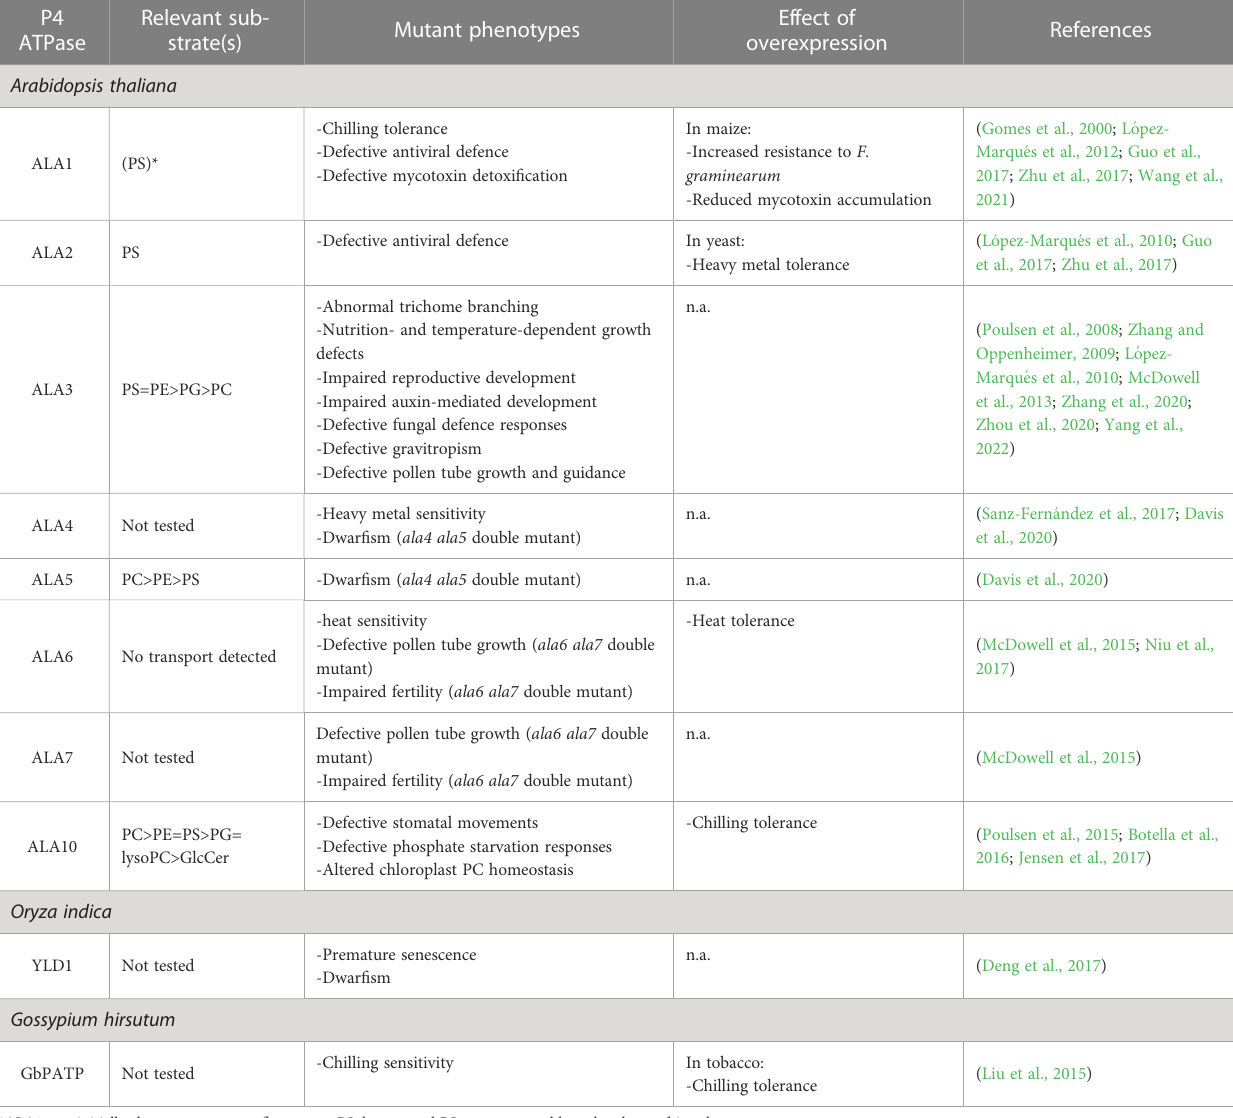
TABLE 1 Substrate speci fi city and physiological functions of plant P4